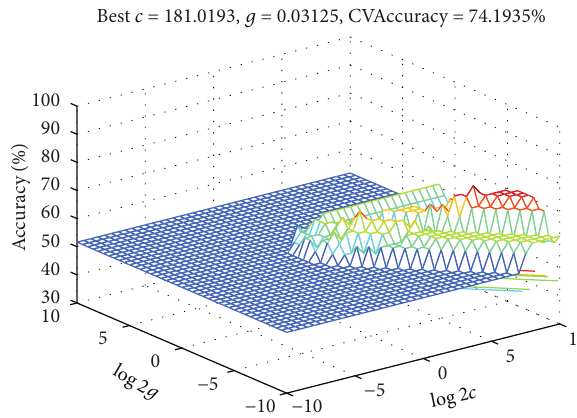
Figure 6: Cross-validation optimized three-dimensional display.